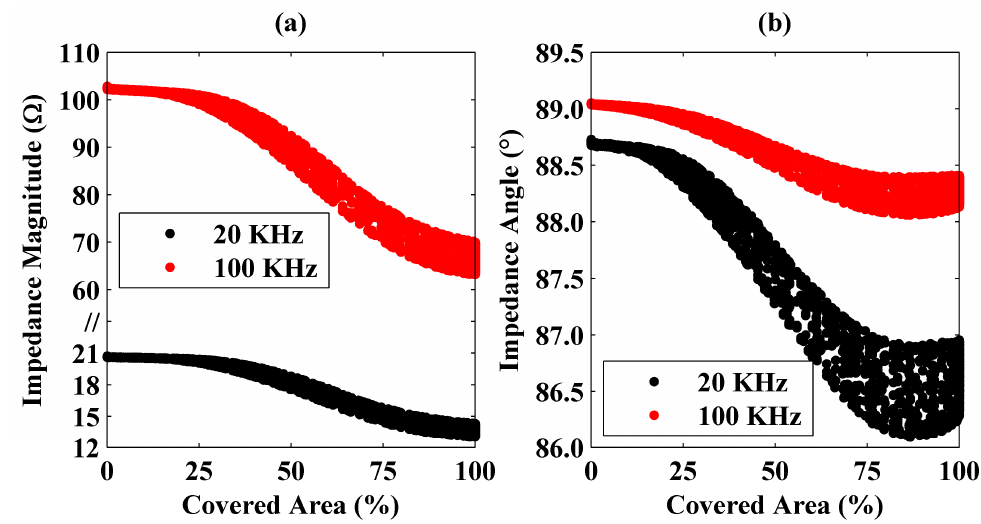
Figure 7. Changes of the impedance magnitude ( a ) and angle ( b ) at 20 and 100 KHz frequencies as a function of the coil area covered by the aluminum plate. Here, in part ( a ), the y axis is scaled nonuniformly for better representation of the calculated magnitudes at different frequencies.